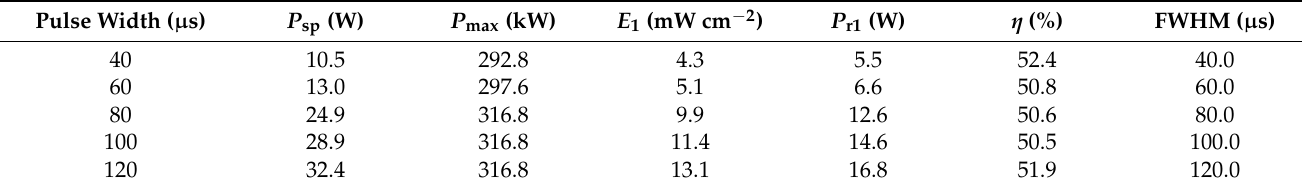
Table 1. Photoelectric parameters of pulsed xenon lamp under different pulse widths.